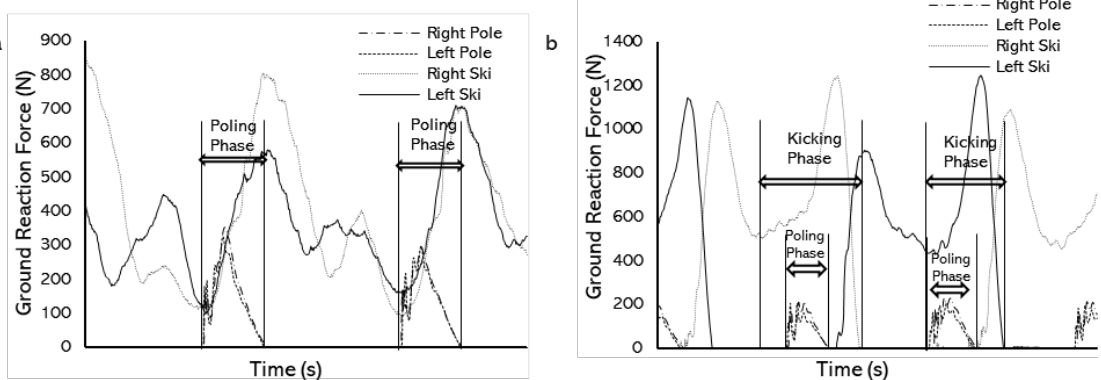
Figure 5. Definition of the force producing phase of DP and V2 techniques: ( a ) GRFs from skis and poles in the DP technique and the definition of the poling phase. ( b ) GRFs from skis and poles in the V2 technique and the definition of the kicking phase.